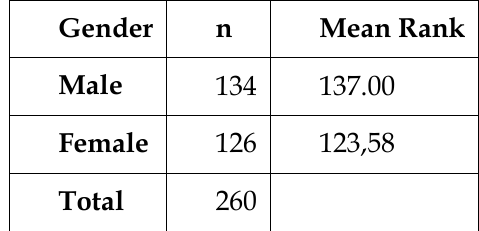
Table 33. Willingness to use the Digital Health Centre and gender. Mann-Whitney U mean